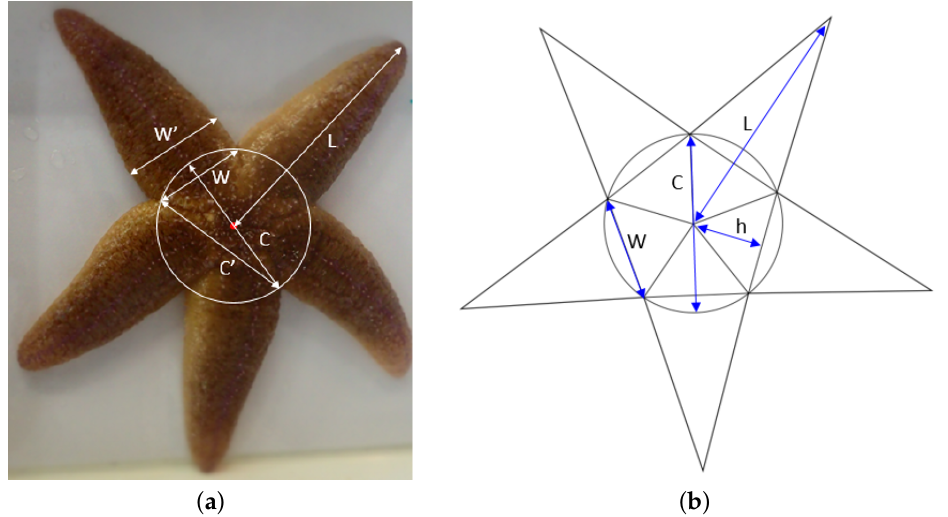
Figure 1. Common sea star ( Asterias rubens ) picture and geometric model. ( a ) Sea star with definition of the measured arm width W (cid:48) , size of central disc C (cid:48) and length L . ( b ) The geometric sea star model with definition of arm width W , diameter of central disc C and length L . The apothem of the pentagon inscribed by the central disc h is used in (2.3) to derive an expression for the area of the geometric